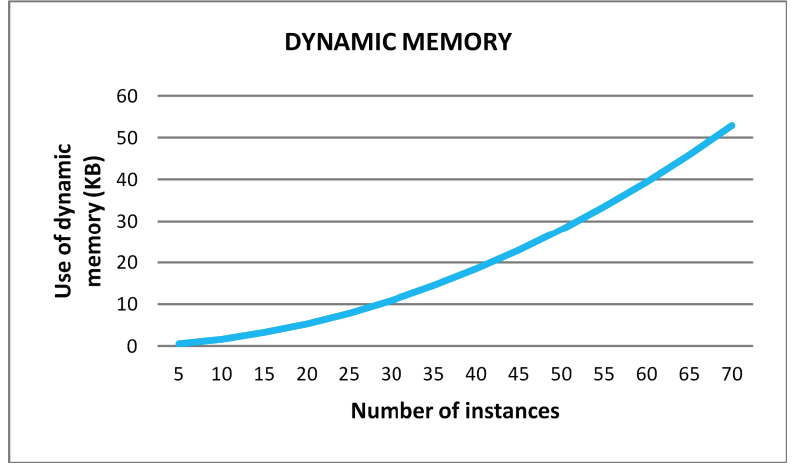
Figure 23. Evolution of the dynamic memory with the number of